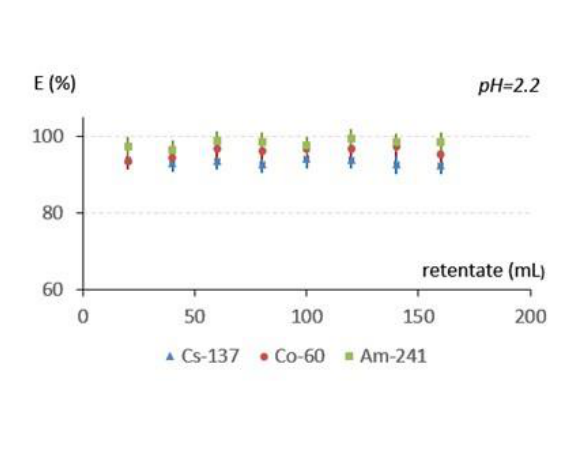
Figure 3. Removal of Cs(I), Co(II) and Am(III) radionuclides from simulated wastewater; an exam- ple run for pH = 2.2 ( left ) and the pH dependence ( right ).